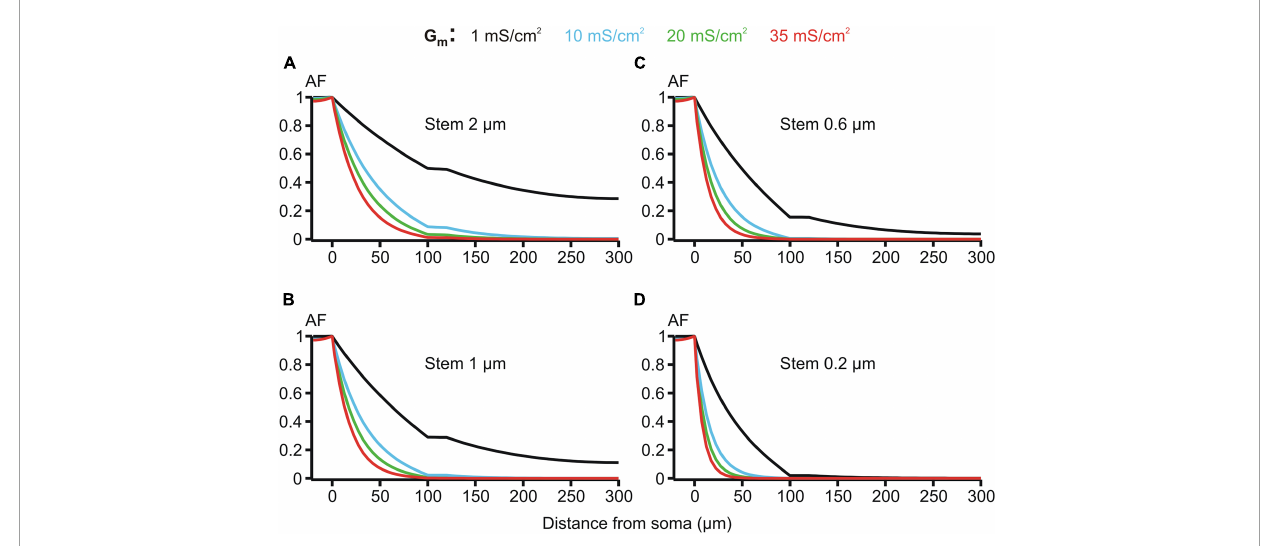
FIGURE7 Attenuation factor AF(x) (ordinate, dimensionless) in function of the path distance from soma x (abscissa, µ m) for different values of the membrane conductivity G m = 1, 10, 20, and 35 mS/cm 2 (color-coded) of the dendrites having different stem diameters D stem = 2, 1, 0.6, and 0.2 µ m (A–D) and the same varicosity (length 20 µ m; diameter 6 µ m).